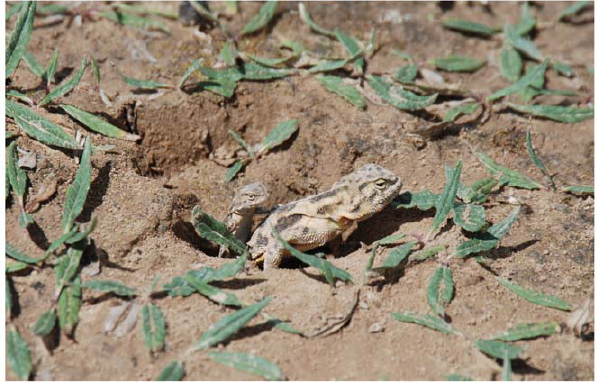
Figure 1. Female Phrynocaphalusvlangalii in a burrow with a young juvenile.